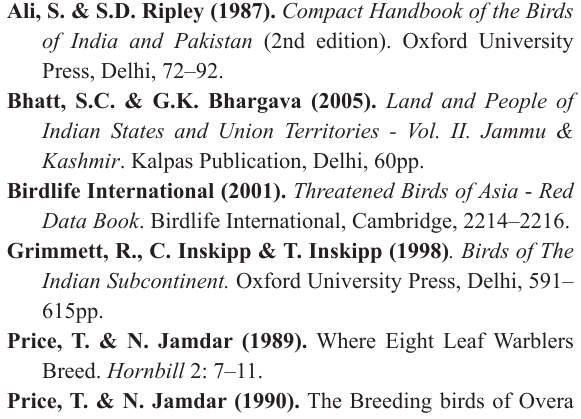
Where H’= Shannon-Weiner diversity index, E’=H’/ln